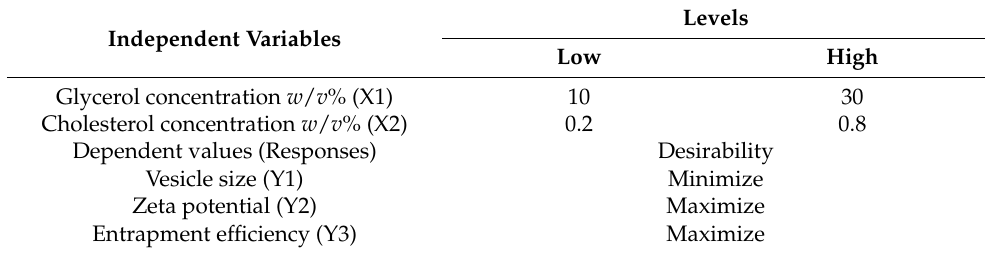
Table 7. Central Composite Design for optimization of QTF loaded